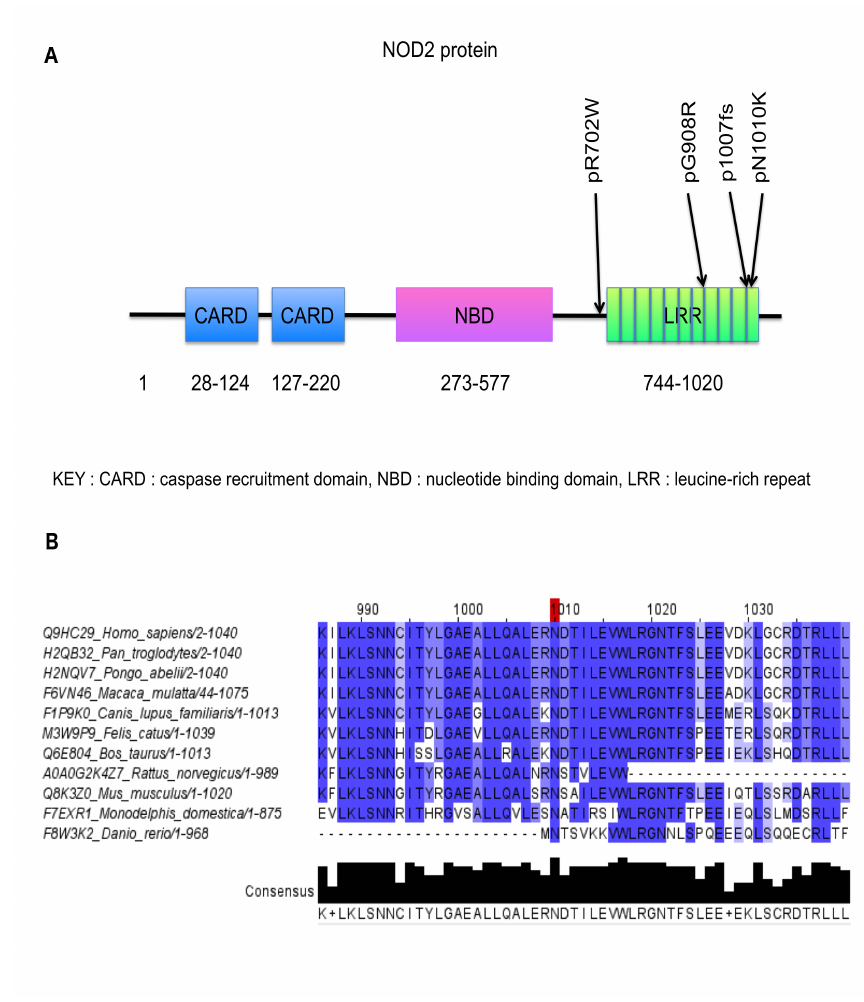
Figure 2. ( A ) Location of the p.R702W (rs2066844), p.G908R (rs2066845), p.L1007fs (rs2066847) and p.N1010K NOD2 protein-altering variations. ( B ) Multiple alignments for the amino acid sequence of the NOD2 proteins in 11 species in agreement with a conserved amino